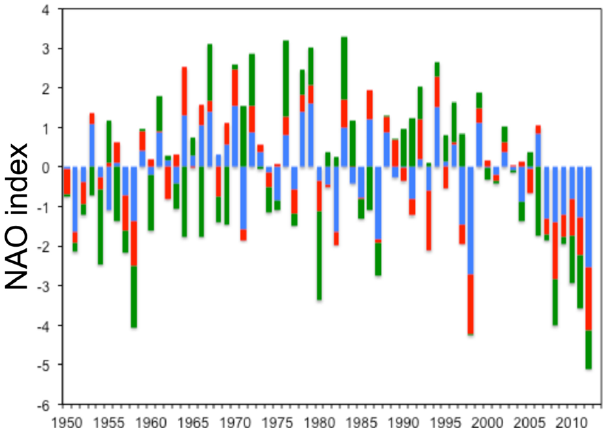
Fig. 12. North Atlantic Oscillation (NAO) index from NOAA Cli- mate Prediction Center for June (blue), July (red), and August (green) for the period